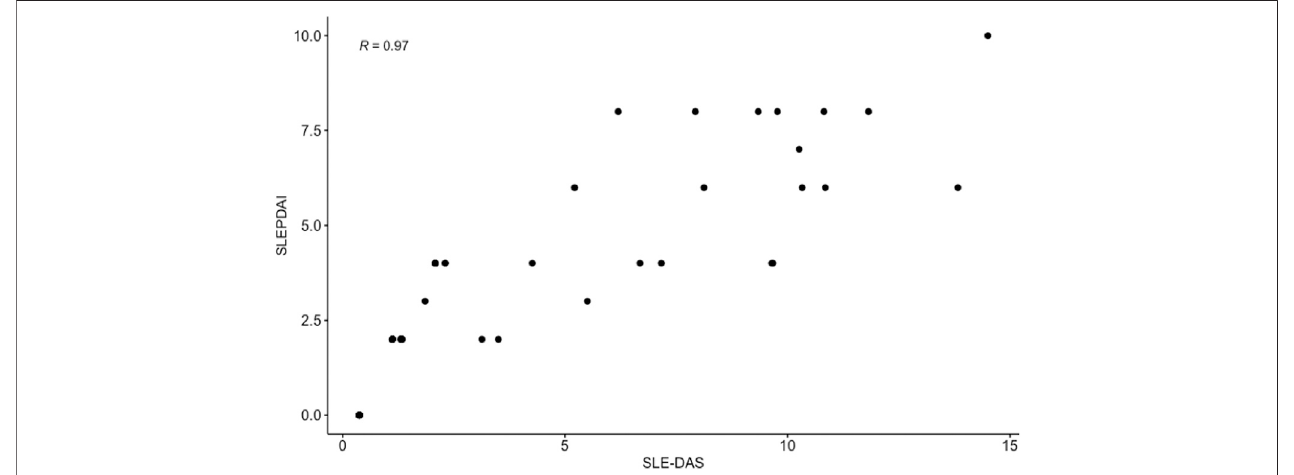
FIGURE 1 | Correlation between SLEPDAI and SLE-DAS at fi rst